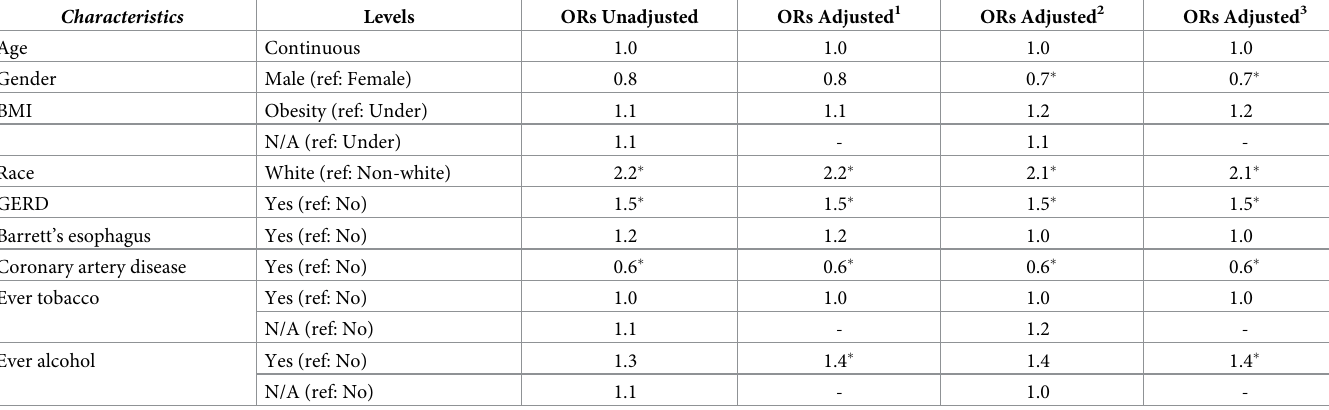
Table 3. Adjusted analyses of relationship between known EAC risk factors with prior tonsillectomy.